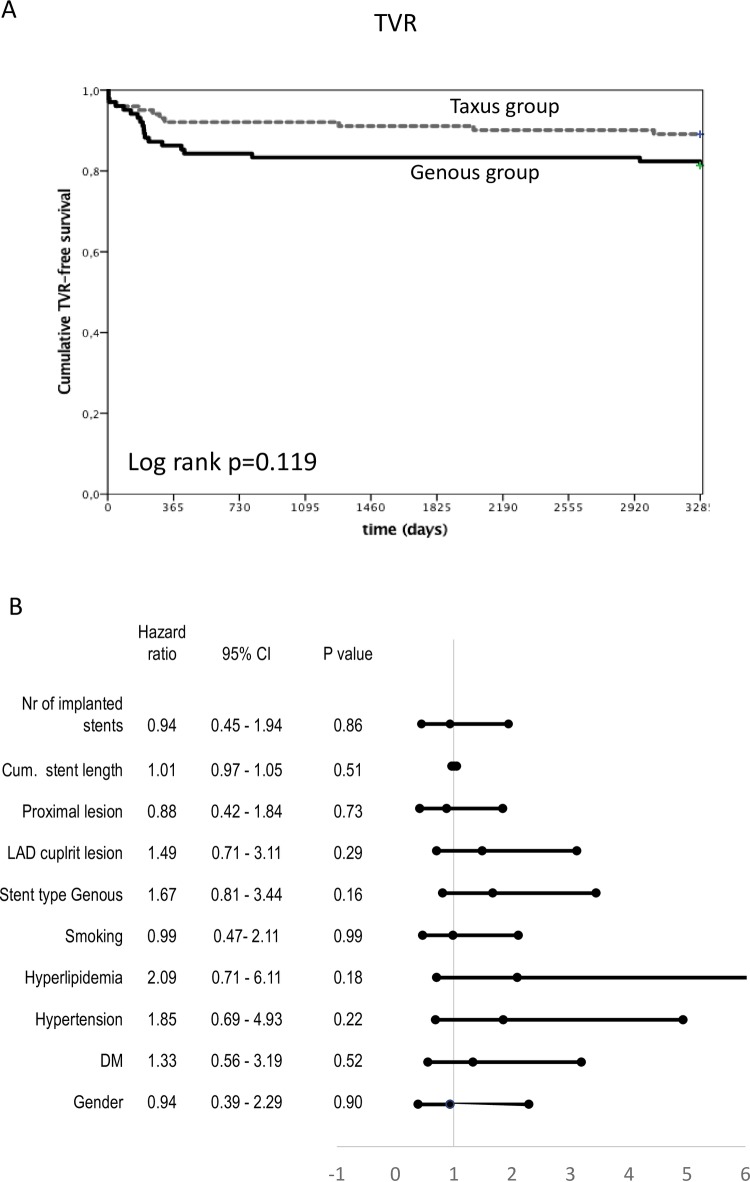
Kaplan-Meier analysis of target vessel revascularization (TVR)-free survival in patients with STEMI who received Genous or TAXUS Liberté stents in primary percutaneous coronary intervention.(A) Cumulative TVR-free survival. (B) Forest plot of TVR-free survival in the indicated subgroups. CI = confidence interval; DM = diabetes mellitus; LAD = left anterior descending coronary artery; Nr = number.